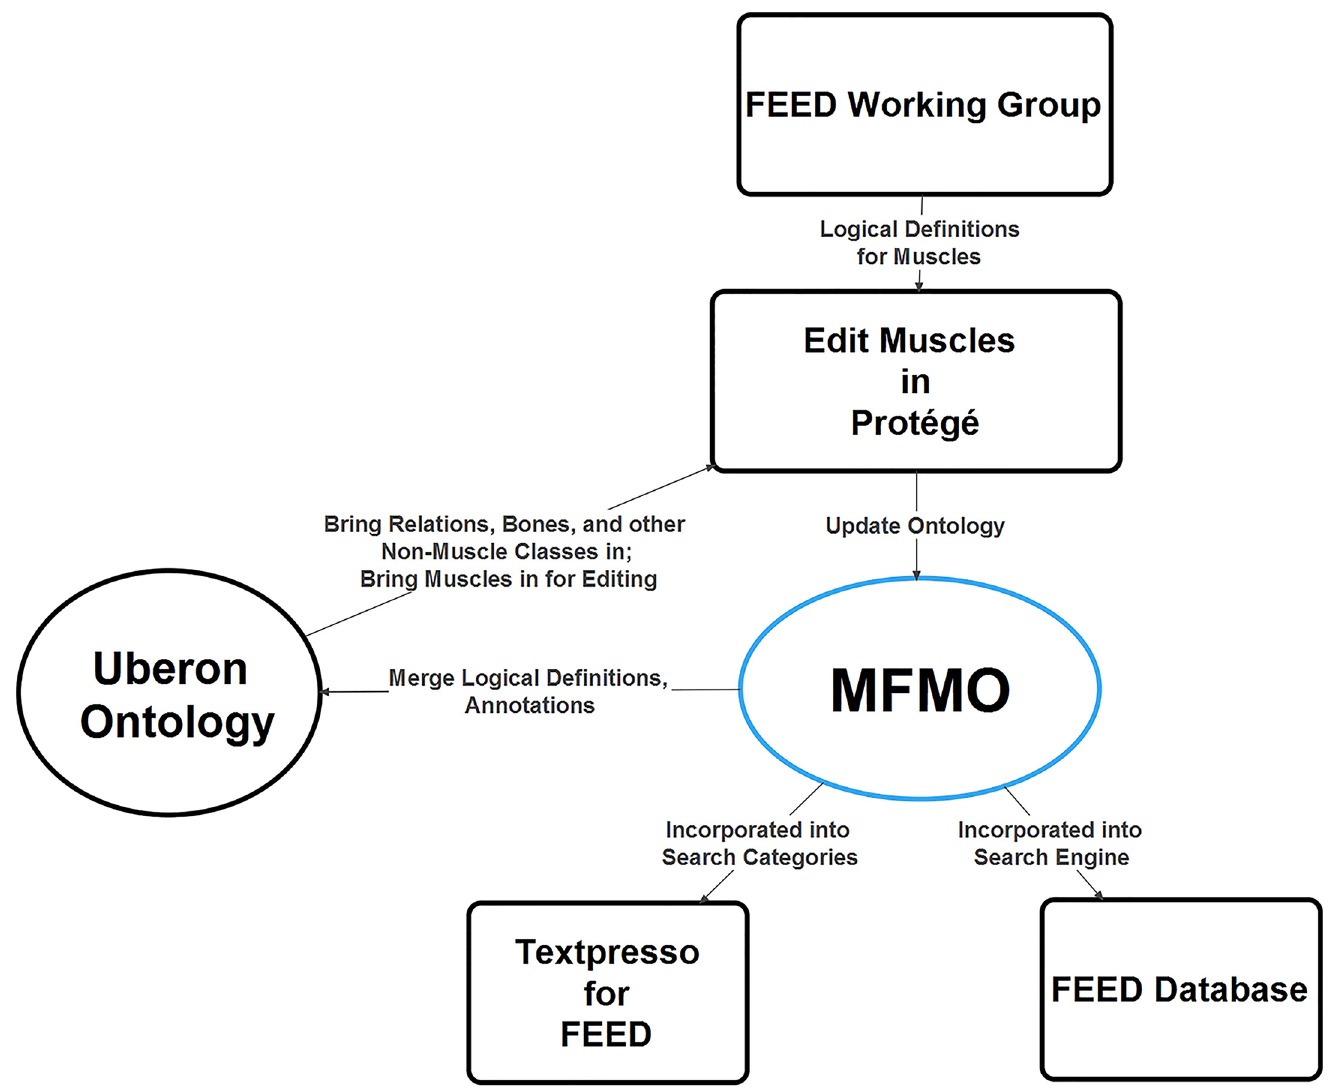
Fig 1. Work flow for the development of the MFMO and deployment for use cases. Creation of the MFMO began with the consensus definitions of the FEED Working Group, which were turned into logical definitions and then annotated in OWL using the Protégé software, with relations and classes imported from Uberon and other ontologies. The use-cases test the competency of the MFMO through queries in Protégé, FEED, and two Textpresso sites (see